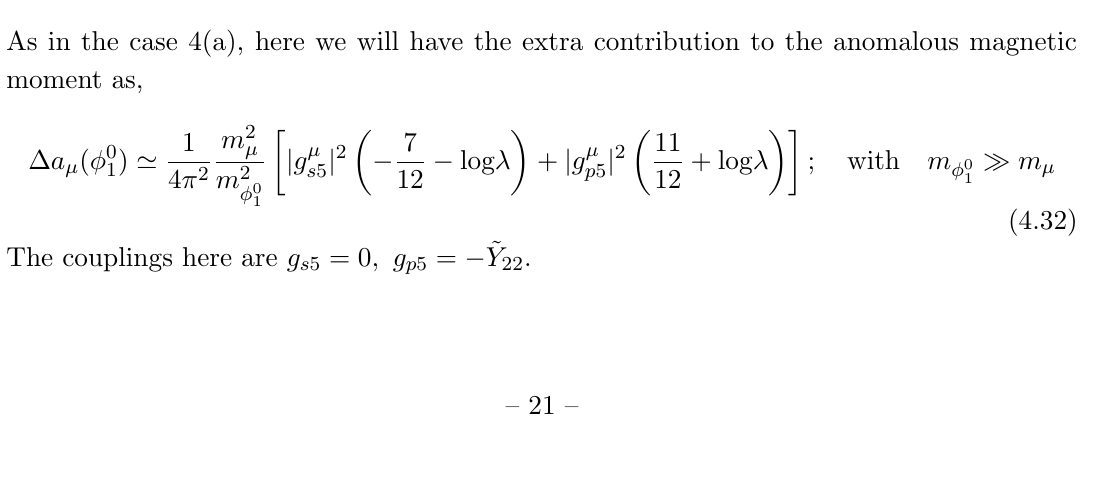
mediation; (cid:1) a 1